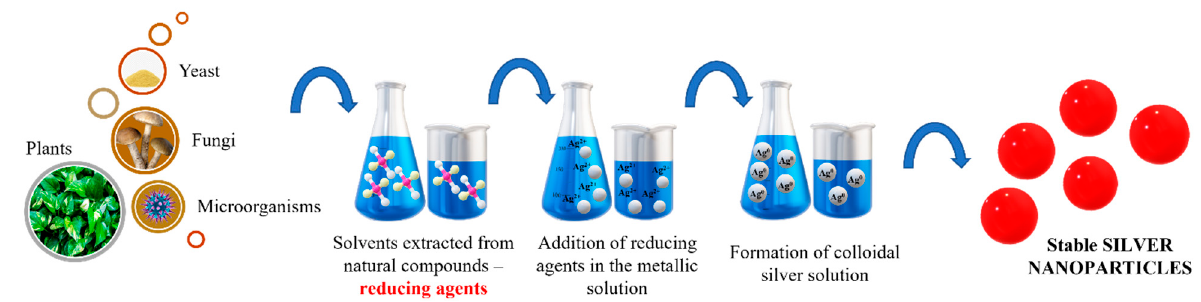
Figure 5. General green synthesis starting from natural compounds in Ag NPs synthesis.